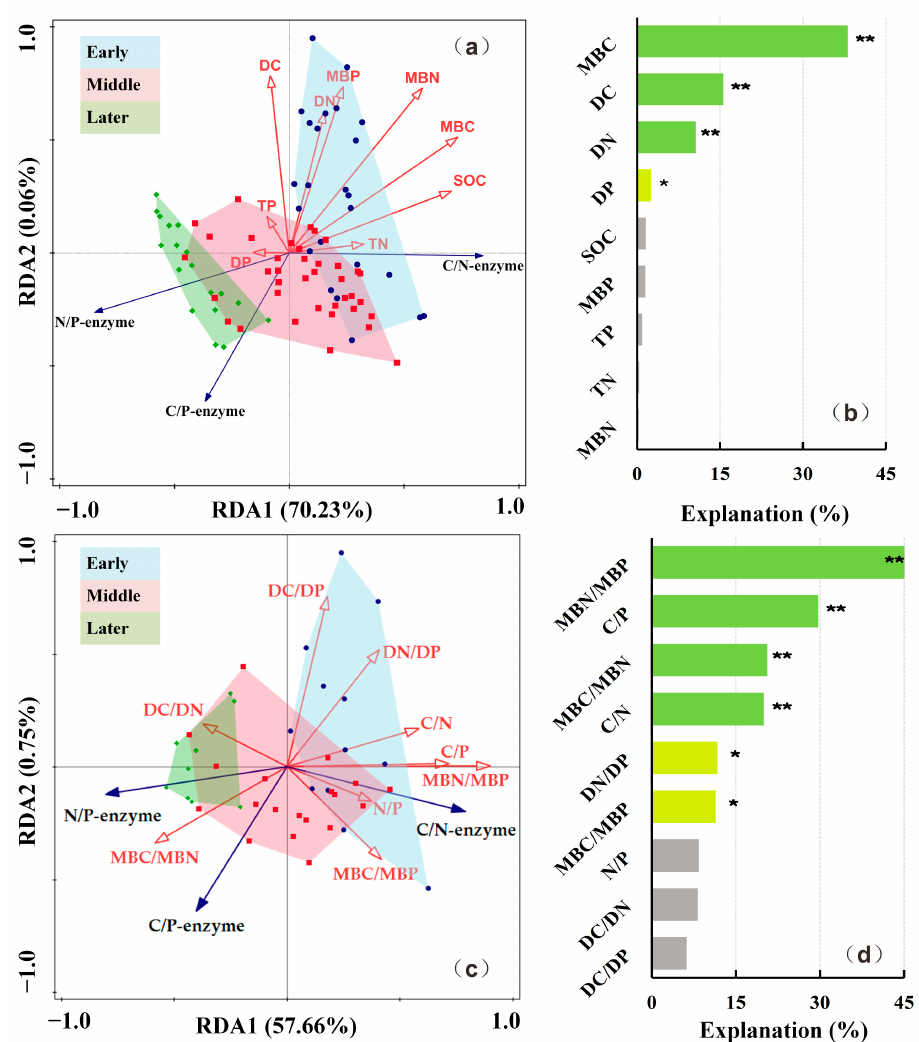
Figure 7. Redundancy analysis (RDA) identifies the relationships between extracellular enzymatic stoichiometry (EES) and ( a , b ) microbial biomass, total nutrients, dissolved nutrients, and ( c , d ) their stoichiometry. * p < 0.05, ** p <